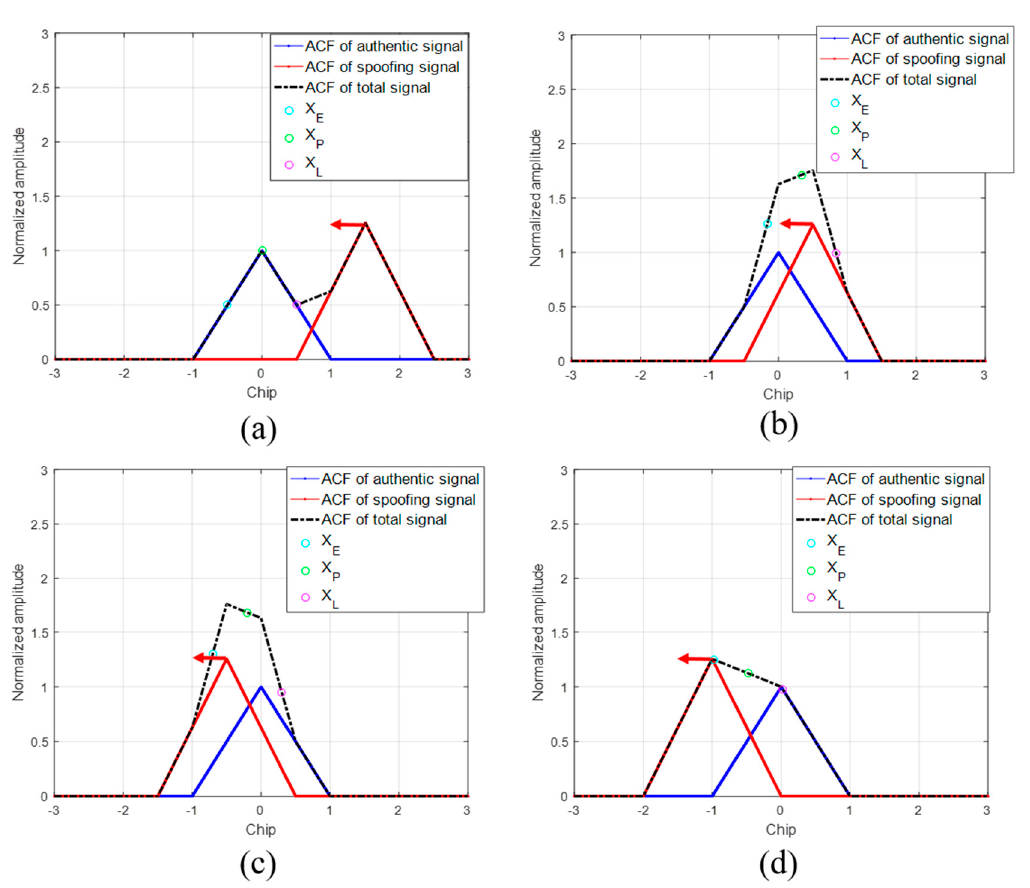
Figure 3. ACF variation with respect to the difference in the code phases between the authentic and spoofing signals. ( a ) D = 1.5; ( b ) D = 0.5; ( c ) D = − 0.5; ( d ) D = − 1.